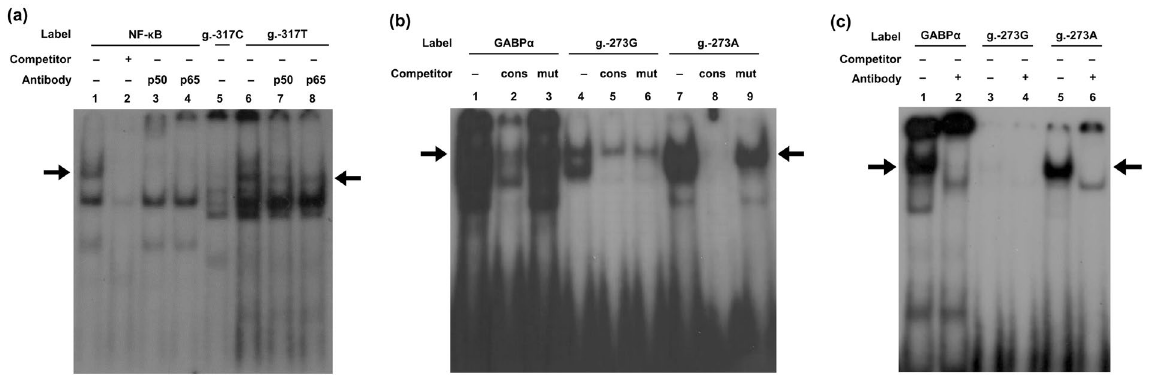
Figure 2. EMSAs for identification of the interaction between SHP-2 promoter variations and transcription factors. ( a ) 32 P-labeled oligonucleotides (lanes 1–3, NF- κ B consensus; lanes 4–6, g.-317C wild-type; lanes 7–9, g.-317T variant) were incubated with nuclear protein extracts from HCT-116 cells. A competition assay and a supershift assay were conducted using 100-fold molar excess of unlabeled NF- κ B consensus oligonucleotides (lane 2) and antibodies against NF- κ B (lanes 3, 4, 7, and 8), respectively. ( b ) 32 P-labeled oligonucleotides (lanes 1–3, GABP α consensus; lanes 4-6, g.-273G wild-type; lanes 7–9, g.-273A variant) were incubated with nuclear protein extracts. A competition assay was performed using 100-fold molar excess of unlabeled GABP α consensus (cons, lanes 2, 5, and 8) or mutant (mut, lanes 3, 6, and 9) oligonucleotides. ( c ) A supershift assay was performed with the antibody against GABP α (lanes 2, 4, and 6). The arrows indicate DNA-protein